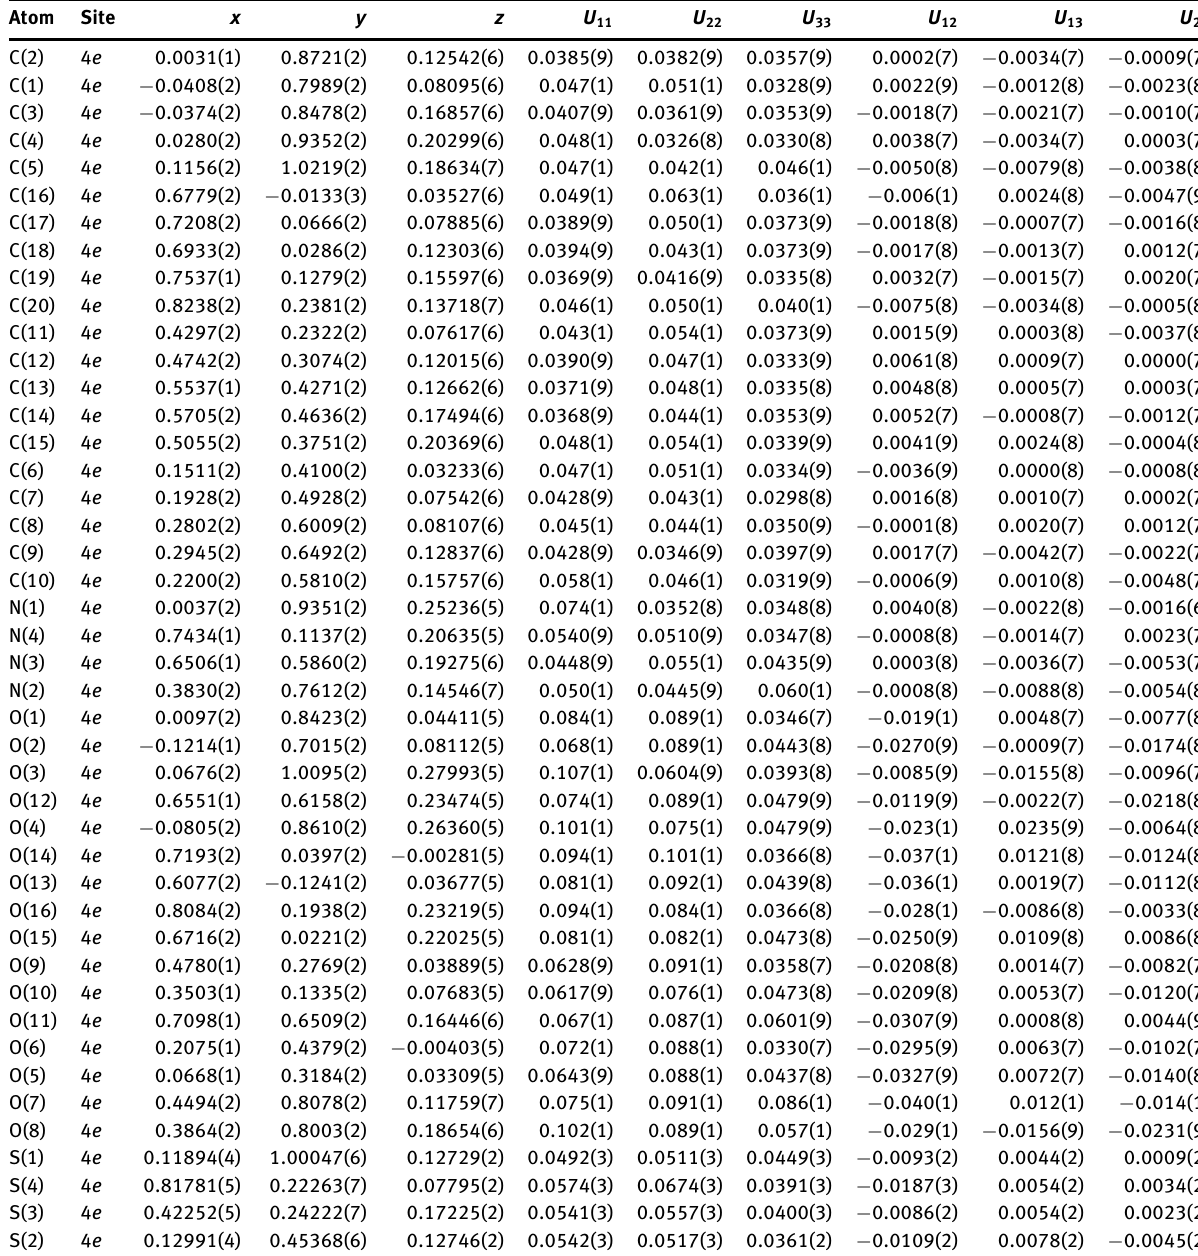
Table 3: Atomic displacement parameters (Å 2